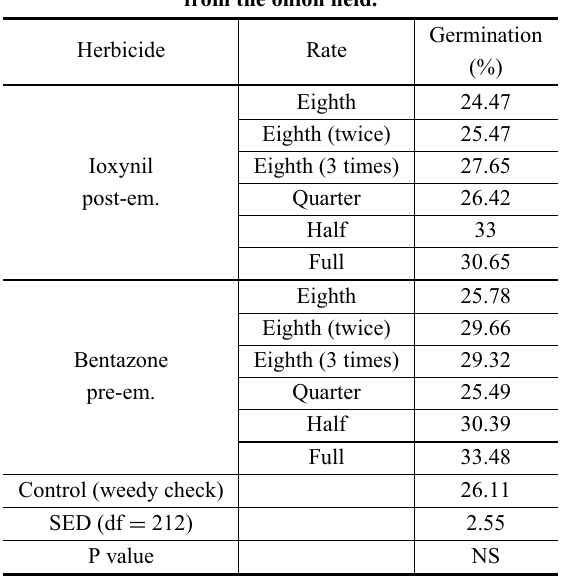
Effects of pre and post-emergence herbicides on the germination (%) of the C. album seed progeny collected from the onion field.